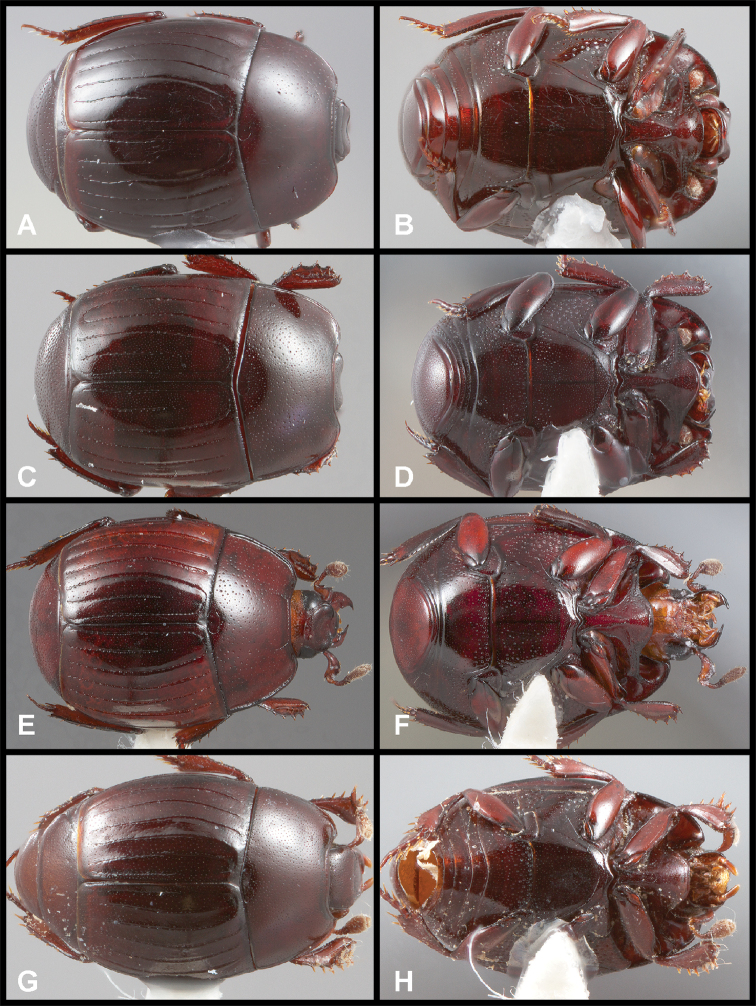
A, BPhelister
morbidus: A dorsal habitus B ventral habitus C, DP.
annulatus: C dorsal habitus D ventral habitus E, FP.
sphaericus: E dorsal habitus F ventral habitus G, HP.
geijskesi: G dorsal habitus H ventral habitus.